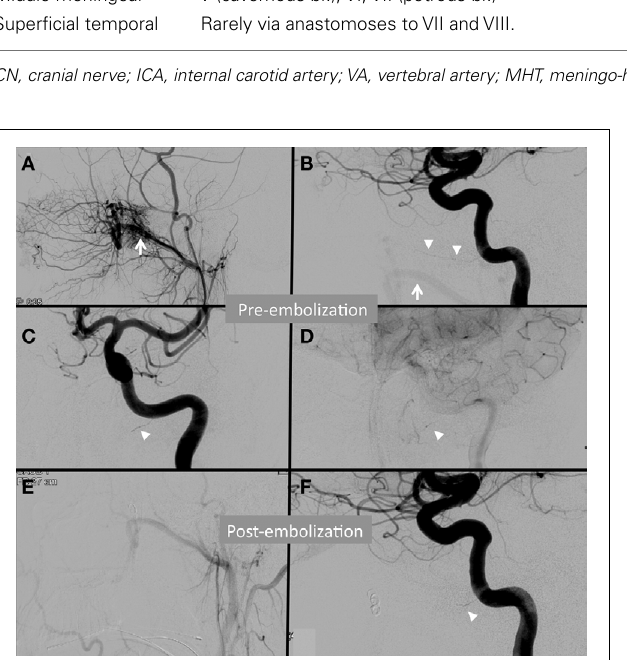
FIGURE 1 |Angiogram from a patient with a juvenile nasopharyngeal angiofibroma (JNA) demonstrating subtle anastomosis between the external and internal carotid arteries via theVidian artery. The left internal maxillary artery (white arrow) supplies a JNA as demonstrated by the left external carotid artery (ECA) injection (A) and the left internal carotid artery (ICA) injection with reflux (B) . AVidian artery is noted (white arrowheads) in the early arterial phase left ICA injection on lateral (B) and anteroposterior (C) injections. Faint opacification of the tumor arises